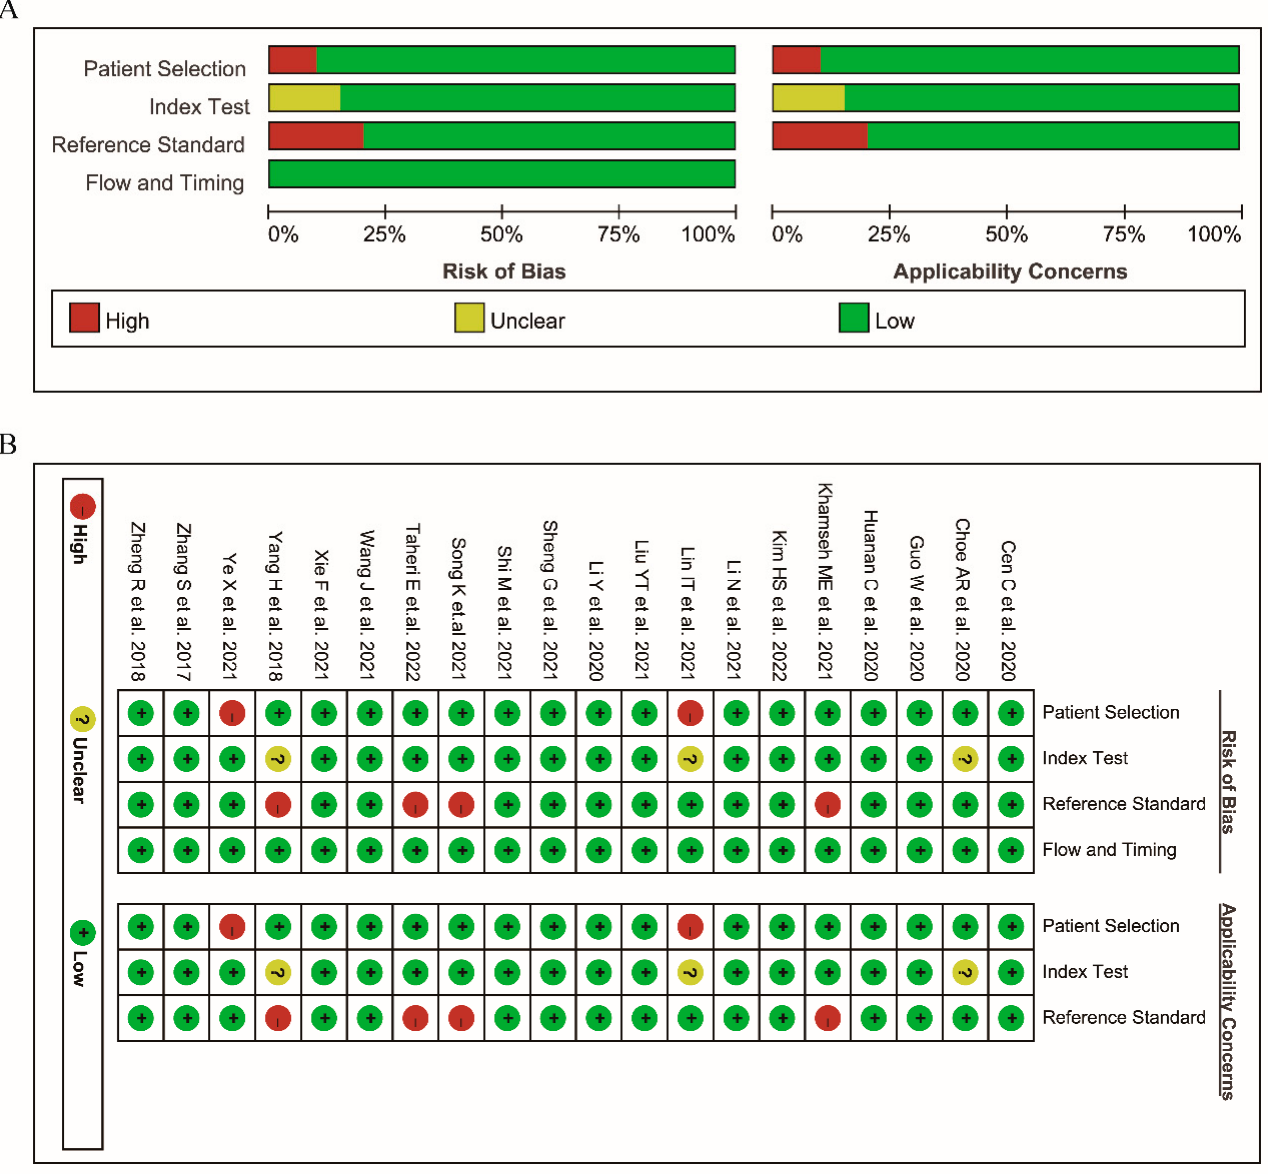
Figure 2. Methodological quality of included studies in accordance to the Quality Assessment of Diagnostic Accuracy Studies-2 (QUADAS-2) tool. ( A ) Overall assessment of the quality for included studies. ( B ) Methodological quality summary for included studies [10,21–39].